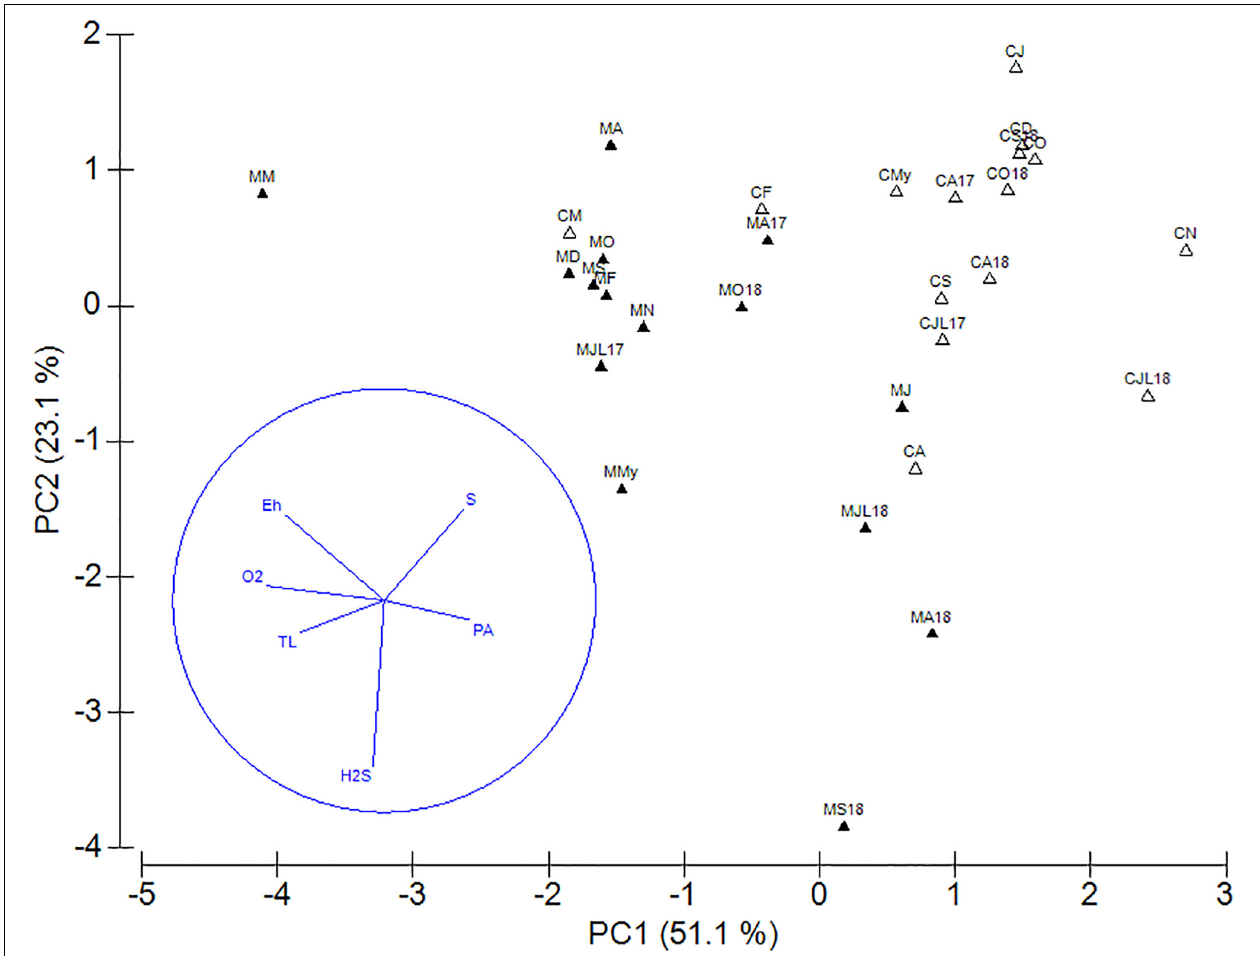
FIGURE 8 | PCA plot of redox potential (Eh), oxygen (O 2 ), hydrogen sulfide (H 2 S), sulfur (S 0 ), total lipids (TL), and prokaryotes (PA) concentrations in the sediment layers (0–4 cm) underlying mixed ( (cid:78) ) and C. cylindracea monospecific settlement ( (cid:49) ). Projections of variables are given in